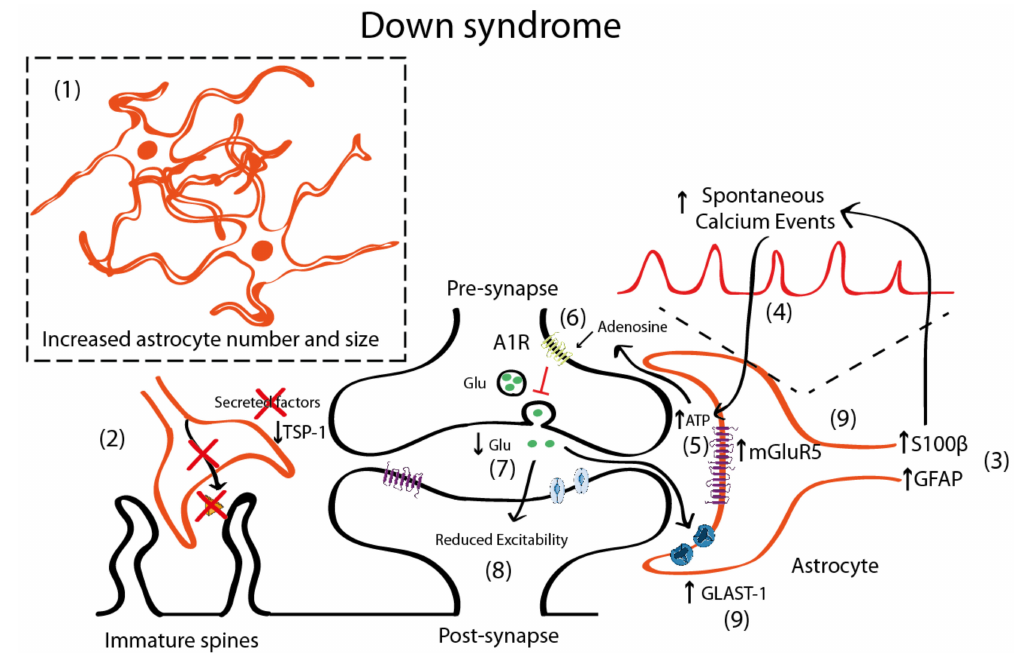
Figure 2. Schematic representation illustrating the astrocyte-synapse alterations in DS. ( 1 ) Astrocyte number and volume is increased in DS. ( 2 ) Reduced astrocyte secreted TSP-1 prevents spine maturation resulting in more frequent filopodia (immature) spines. ( 3 ) Increased S100 β and GFAP expression has been described in astrocytes. S100 β upregulation has been linked with increased astrocyte calcium oscillations ( 4 ). Increased astrocyte activity leads to adenosine triphosphate (ATP) release to the synaptic cleft ( 5 ) that is hydrolyzed to adenosine and activates A1 adenosine receptors (A1R) ( 6 ). A 1 R activation prevents glutamate release from the presynaptic terminal and, consequently ( 7 ) depresses synaptic transmission ( 8 ). Even though mGluR5 is upregulated in astrocytes (and probably in neurons), no mechanistic studies have been performed to uncover the contribution of mGluR5 to DS pathophysiology. ( 9 ) Reduced glutamate concentrations can be contributed by increased expression of the glutamate transporter GLAST-1 that leads to increased astroglial glutamate